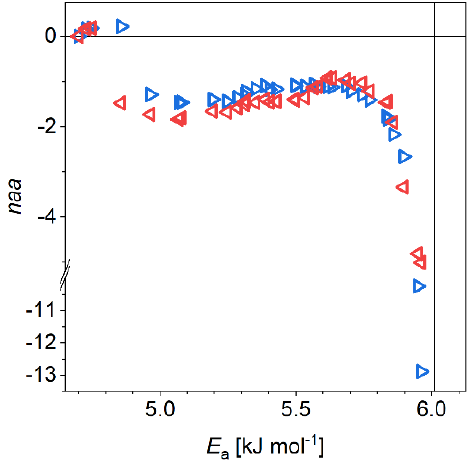
Figure 3. Wild type (red triangles) and A53T (blue triangles) α-synuclein amyloid-oligomer difference melting diagrams. Mol H 2 O per mol amino acid residue ( naa ) vs. potential barrier.